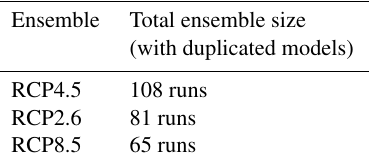
Table 1. Summary of the CMIP5 experiments. RCP4.5 was used as default here, whereas RCP2.6 and 8.5 were taken as lower and upper limits based on different emission scenarios.